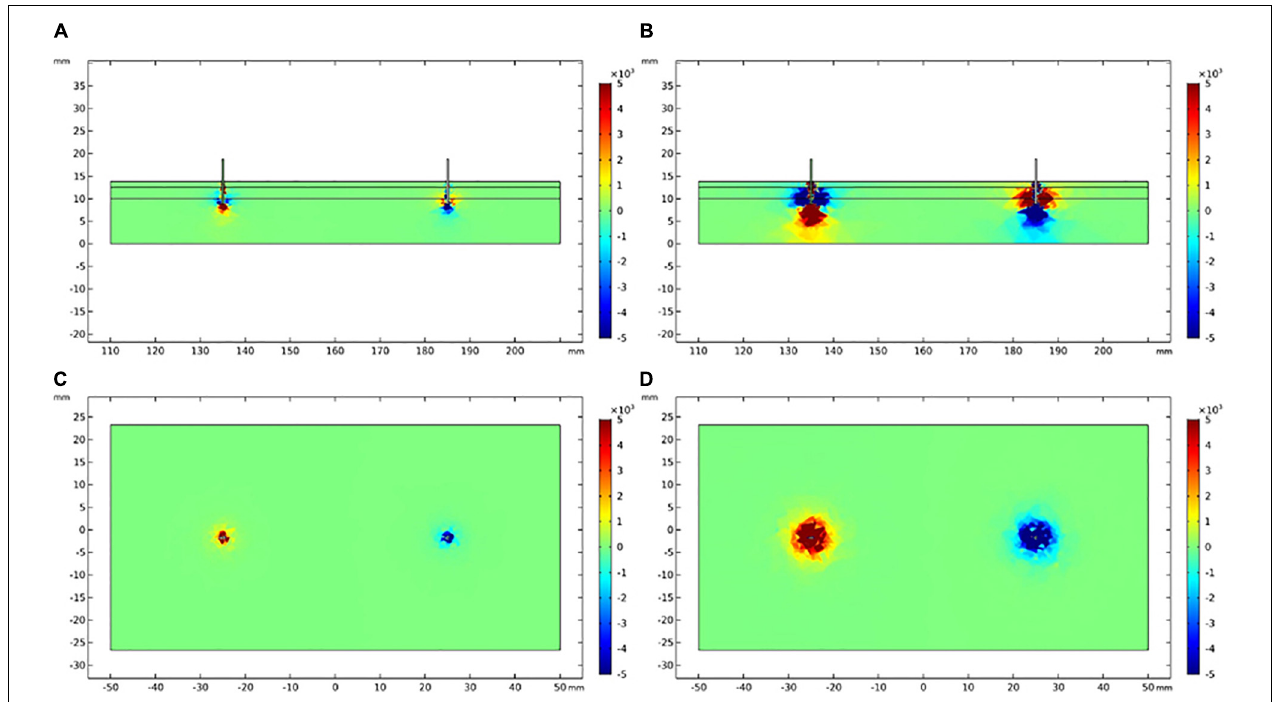
FIGURE 8 | Electric field gradient distribution in TENS at different current intensity. (A) The longitudinal section of electric field gradient at 4 mA; (B) at 15 mA. (C) The cross-section (3 mm depth) of electric field gradient at 4 mA; (D) at 15 mA. Color bar indicates the magnitude of second order electrical field gradient (V/m 2 ).